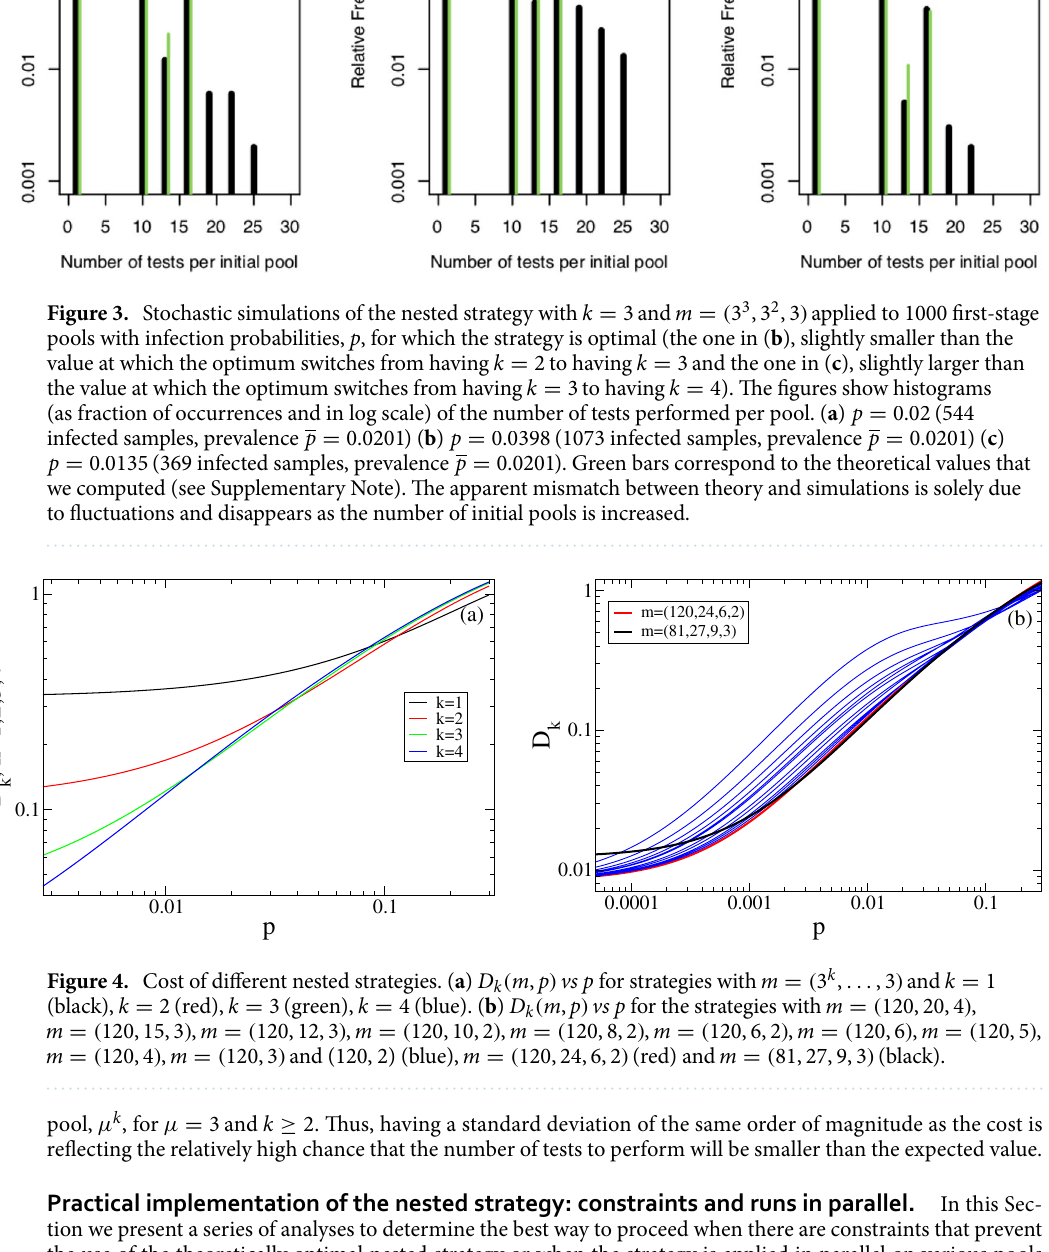
4 (blue). ( b ) D , p ) vs p for the strategies with m k ( m = ( 120, 10, 2 ) , m ( 120, 8, 2 ) , m = = ( 120, 24, 6, 2 ) (red) and m =